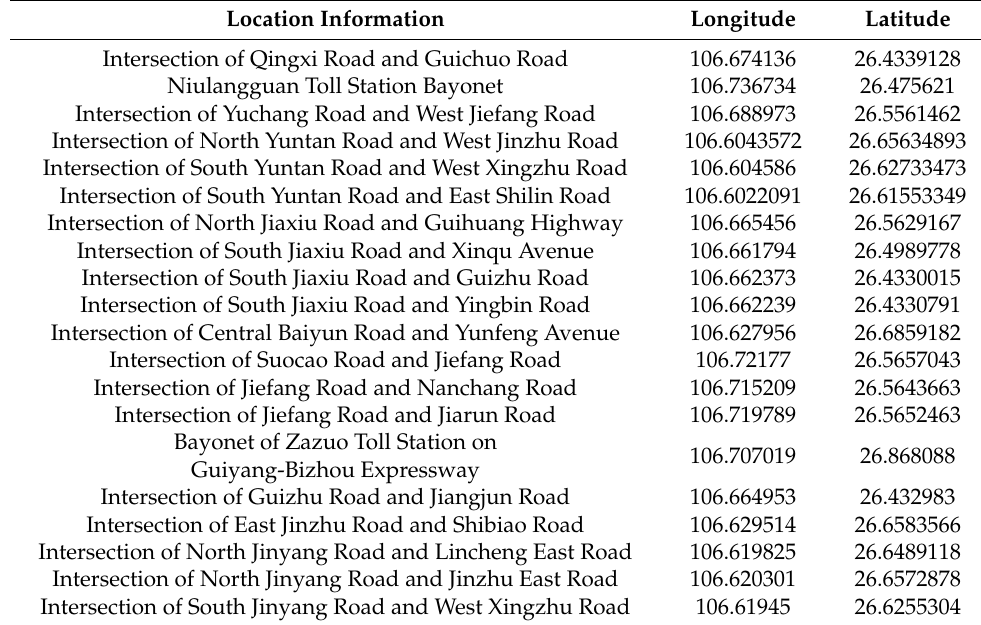
Table 5. Accurate results of partial longitude and latitude data.